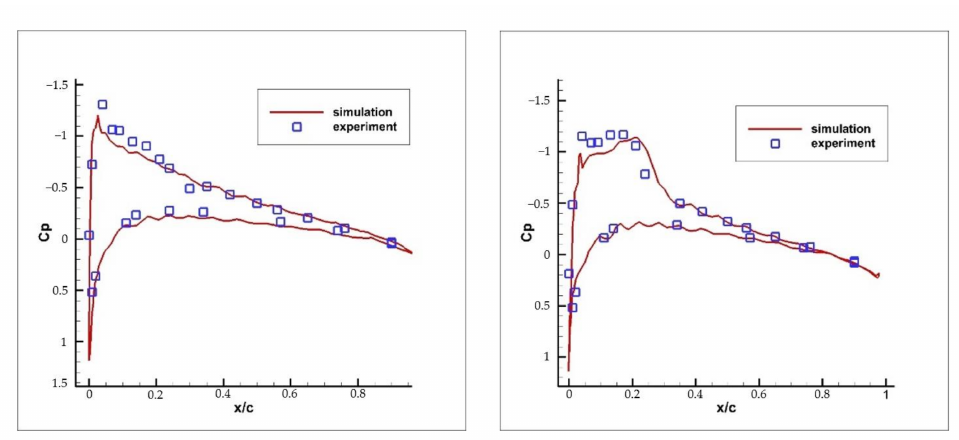
Figure 4. Group 1 Results and Group 2 Results.